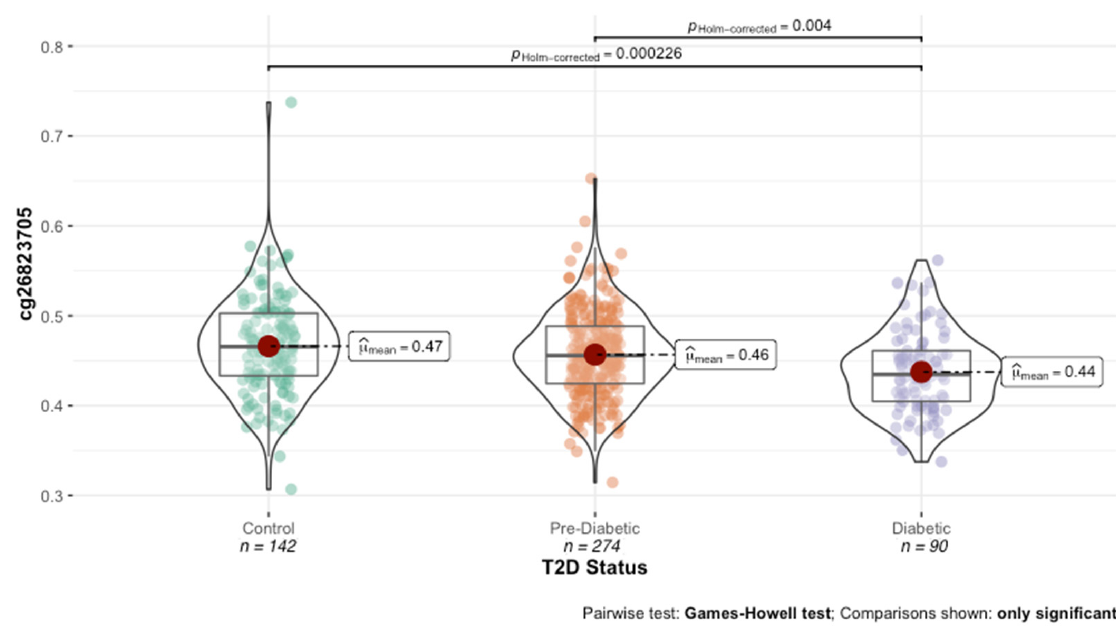
Figure 2. Distribution of cg26823705 across T2D status.